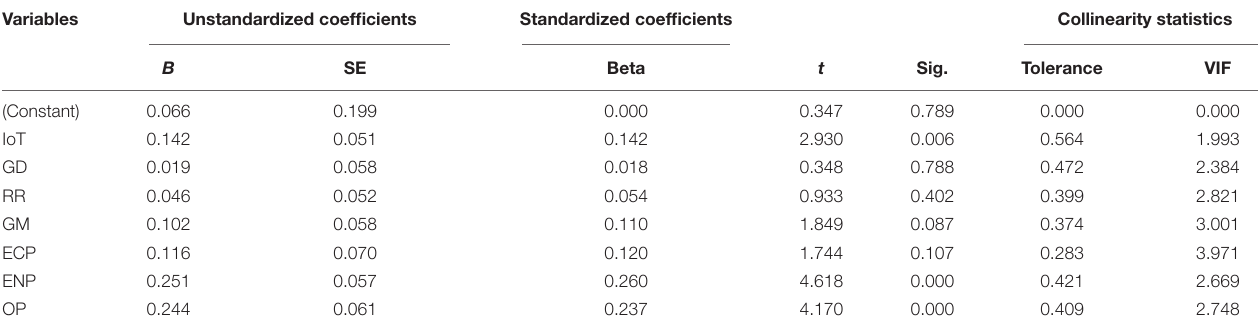
TABLE 7 | Multicollinearity test.